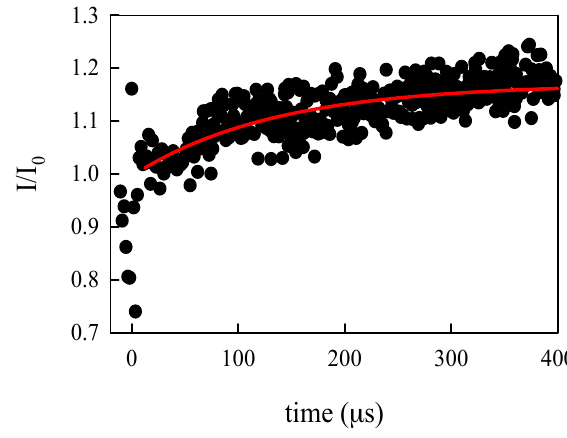
Figure 6. Relative fluorescence of the refolding experiment versus time.